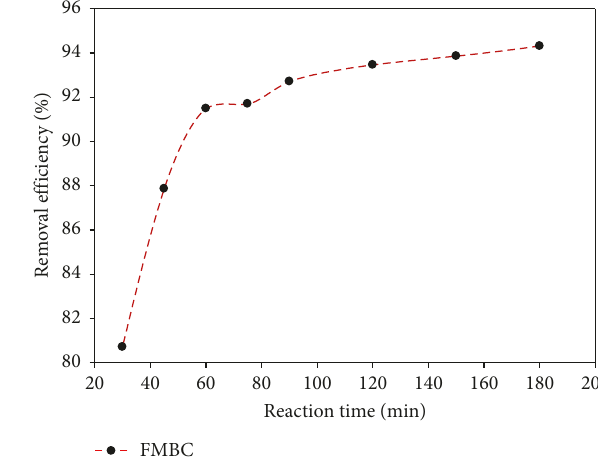
Figure 7: Effect of reaction time for the As(V) removal on FMBC. Figure 5: Effect of pH for the As(V) removal on RB and